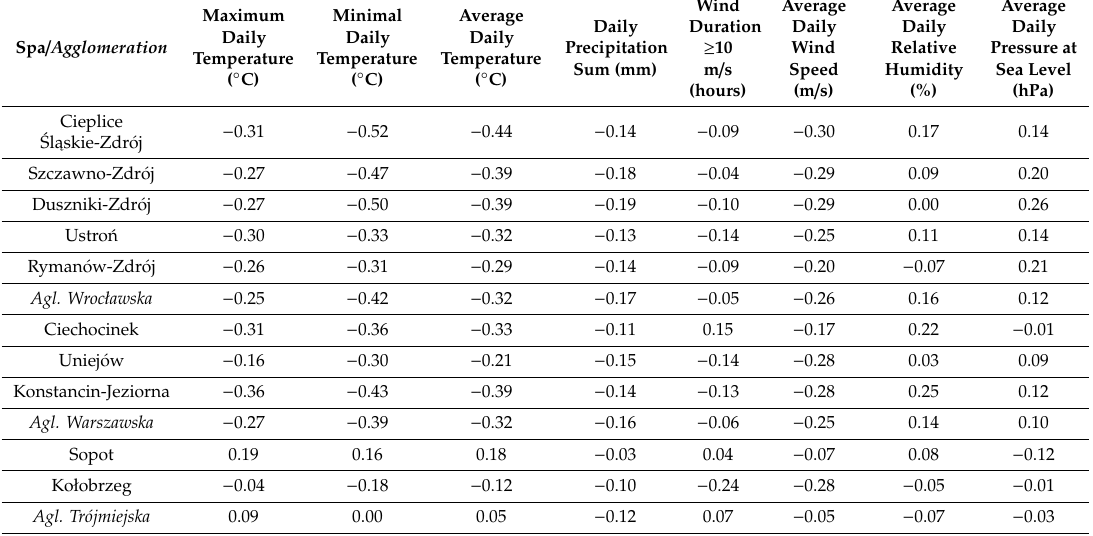
Table 6. Coe ffi cients of correlation of the average daily PM 10 concentrations with the daily values of selected meteorological indicators in the examined spas and agglomerations in